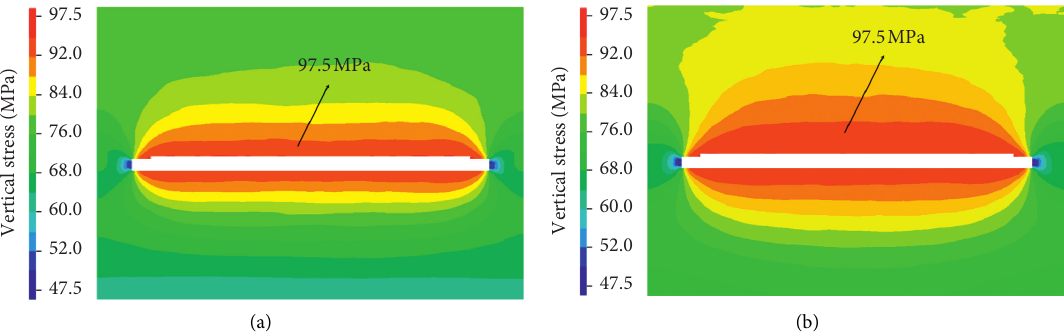
Figure 6: Vertical stress section nephogram of different support types. (a) Single hydraulic prop support. (b) Anchor cable